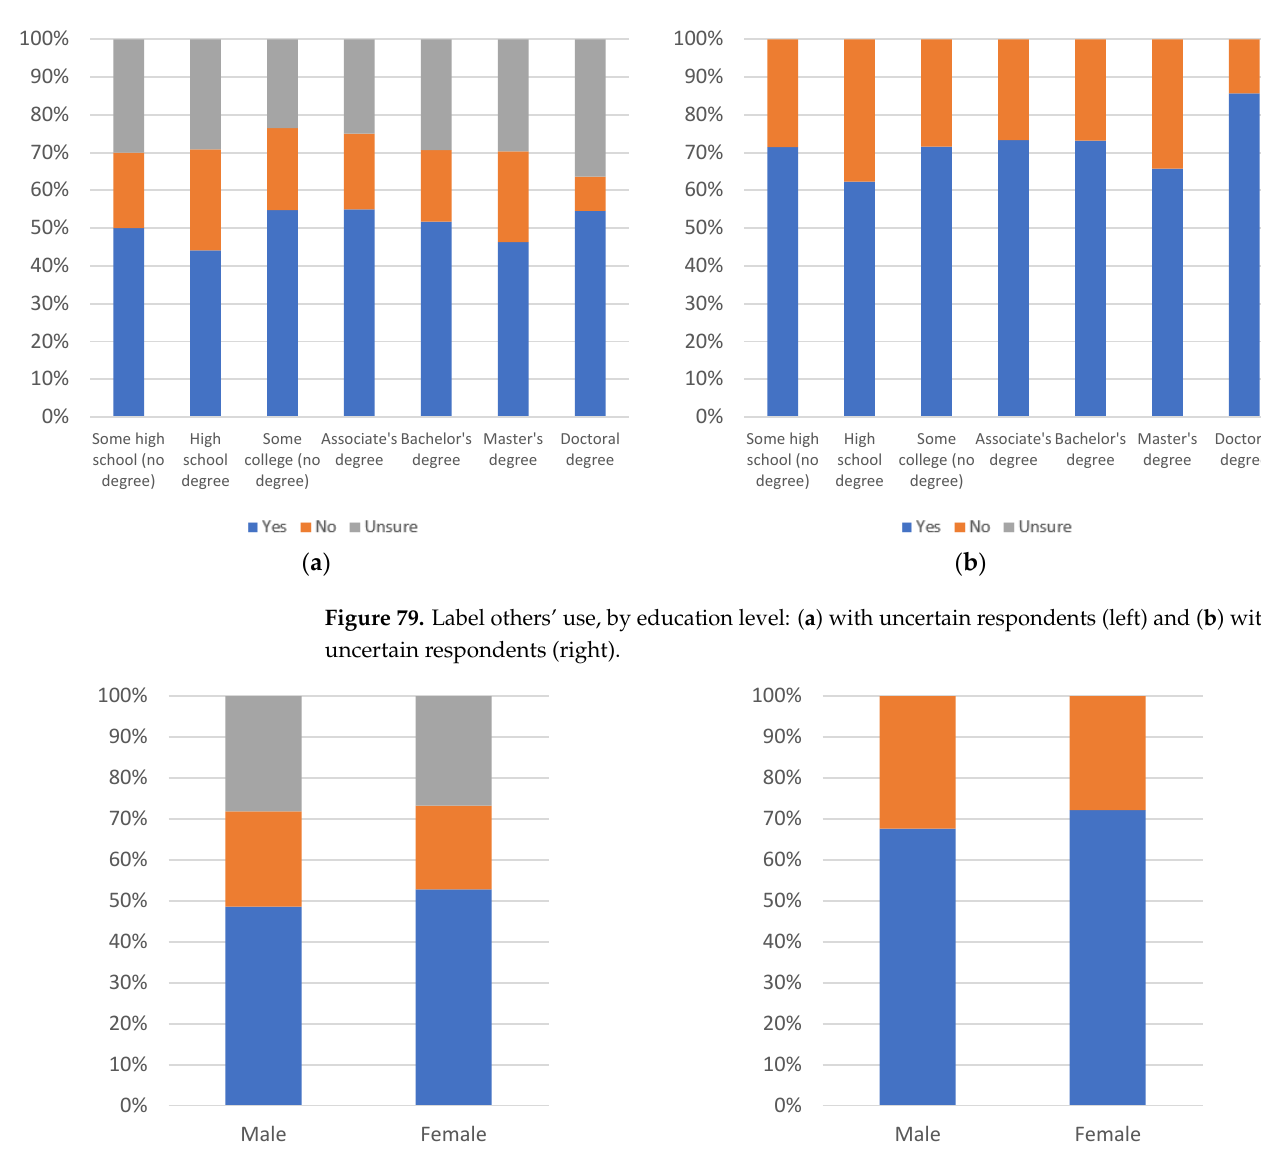
Figure 78. Label others’ use, by ag e group: ( a ) with uncertain respondents (left) and ( b ) without uncertain respondents (right).